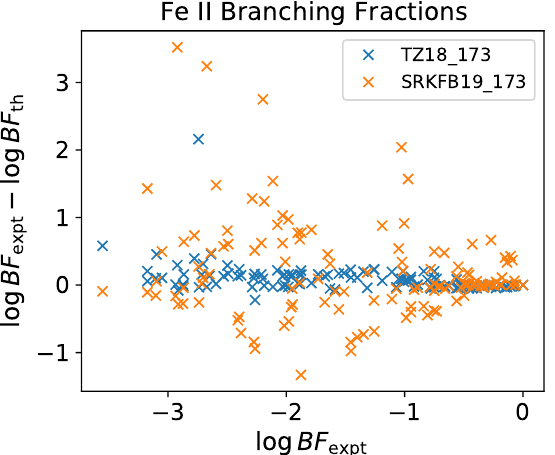
Figure 14. Comparison of Fe II experimental branching fractions ( BF expt ) [48] with theoretical values ( BF th ) derived from atom_TZ18_173 and atom_SRKFB19_173.